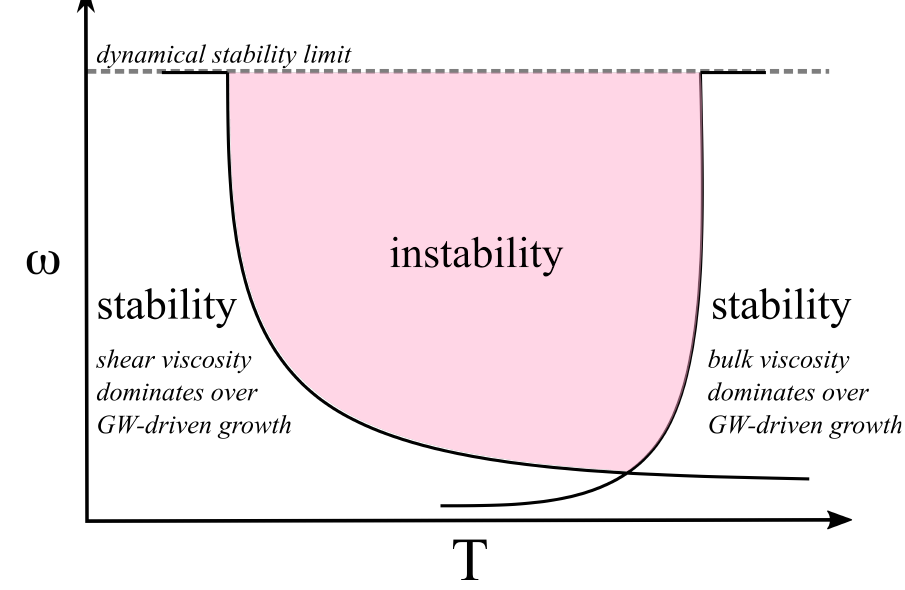
Figure 6. Schematic plot of the window in which r-modes are unstable and lead to CGWs emission. The shape of instability window and NSs evolutionary tracks inside and outside the window are model-dependent (including EOS-dependence, see footnote 14 and e.g., [224,230,231]). For the more detailed review of the topic see